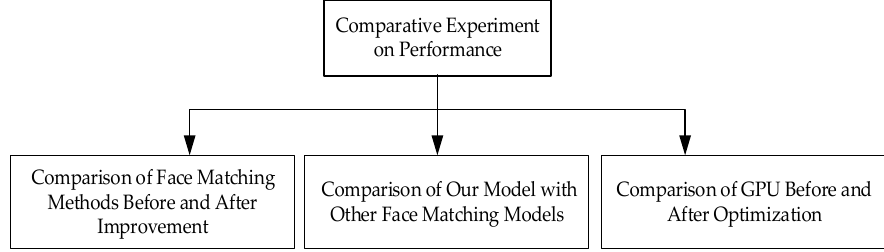
Figure 12. Comparative experiments on performance.